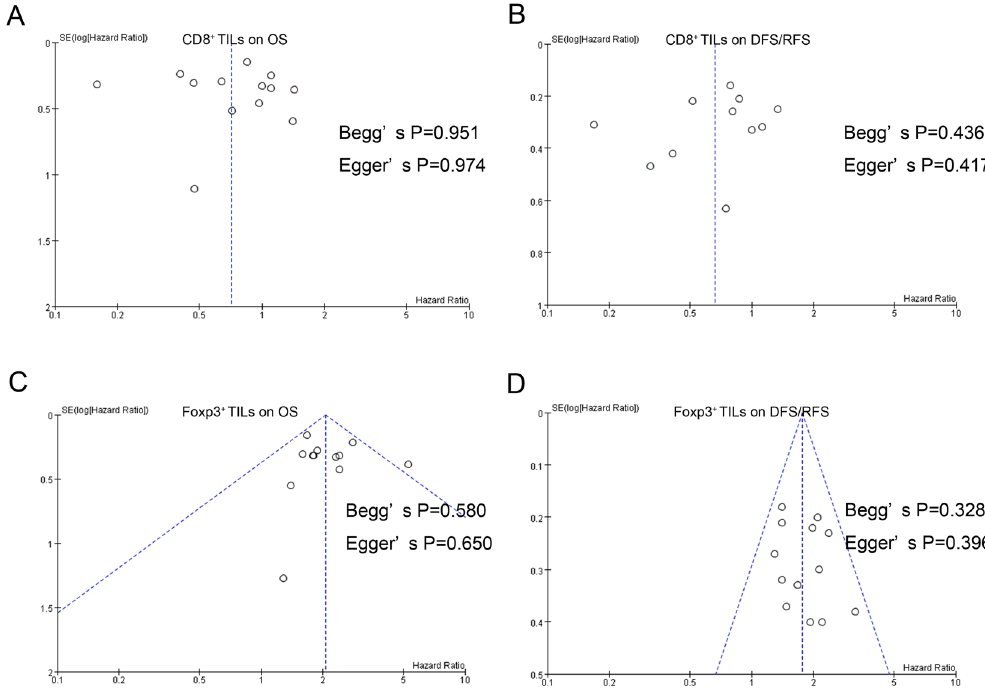
Figure 4. Funnel plots, Begg’s and Egger’s tests of the meta-analyses assessing the associations between TILs cells and survival. ( A ) Studies on the effect of CD8 + T cells on OS. ( B ) Studies on the effect of CD8 + T cells on DFS/RFS. ( C ) Studies on the effect of Foxp3 + T cells on OS. ( D ) Studies on the effect of Foxp3 + T cells on DFS/